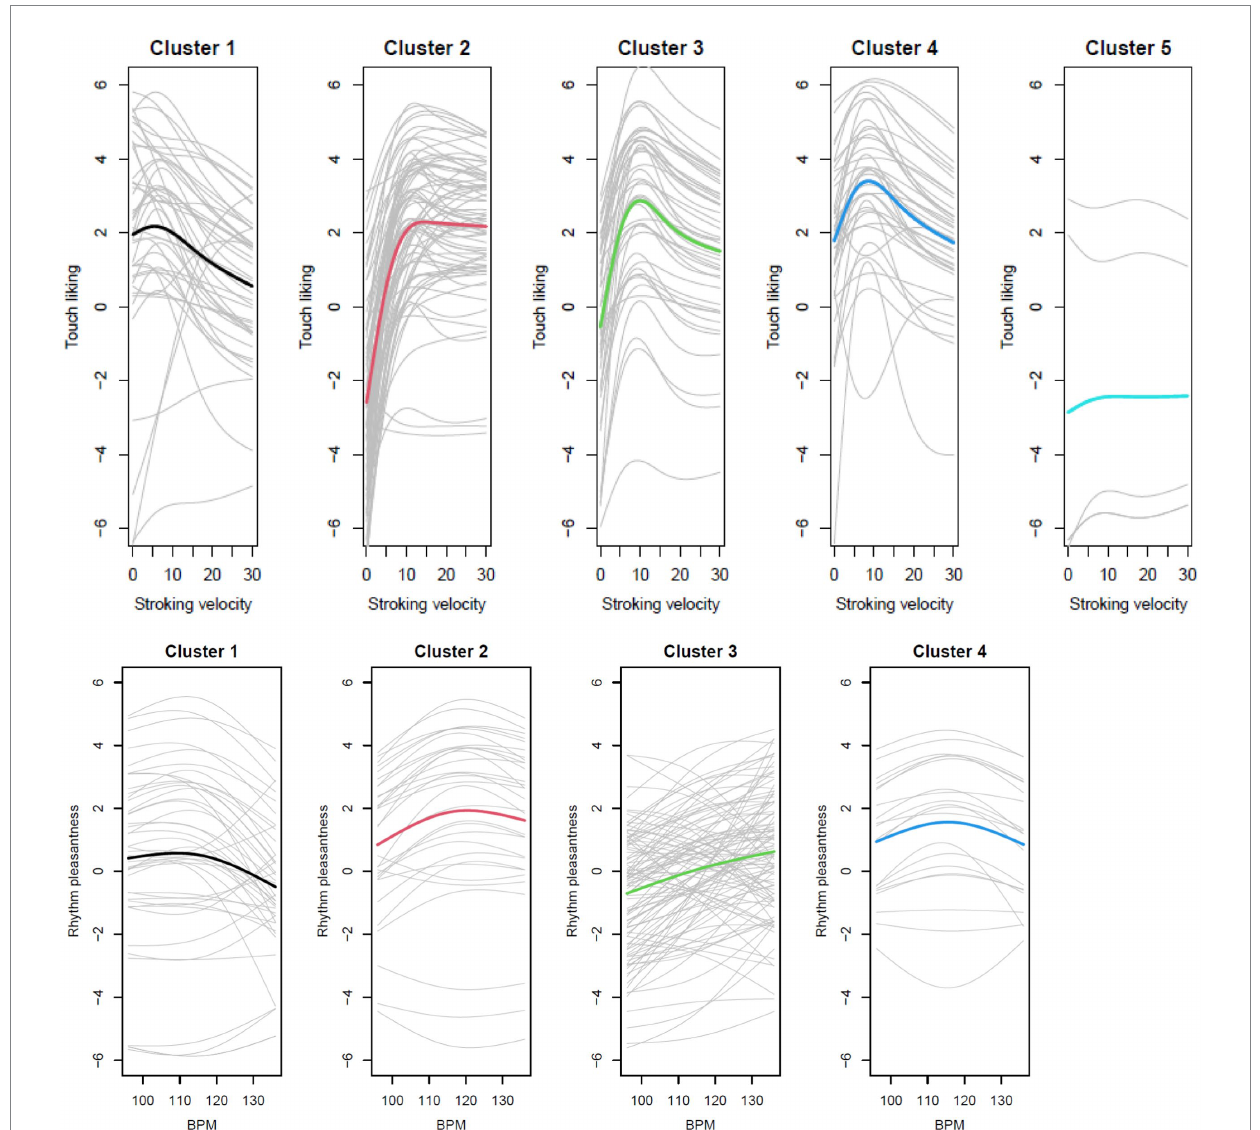
FIGURE 13 Clustering identified five different curve forms for touch ratings (upper) and two different curve forms for beat ratings